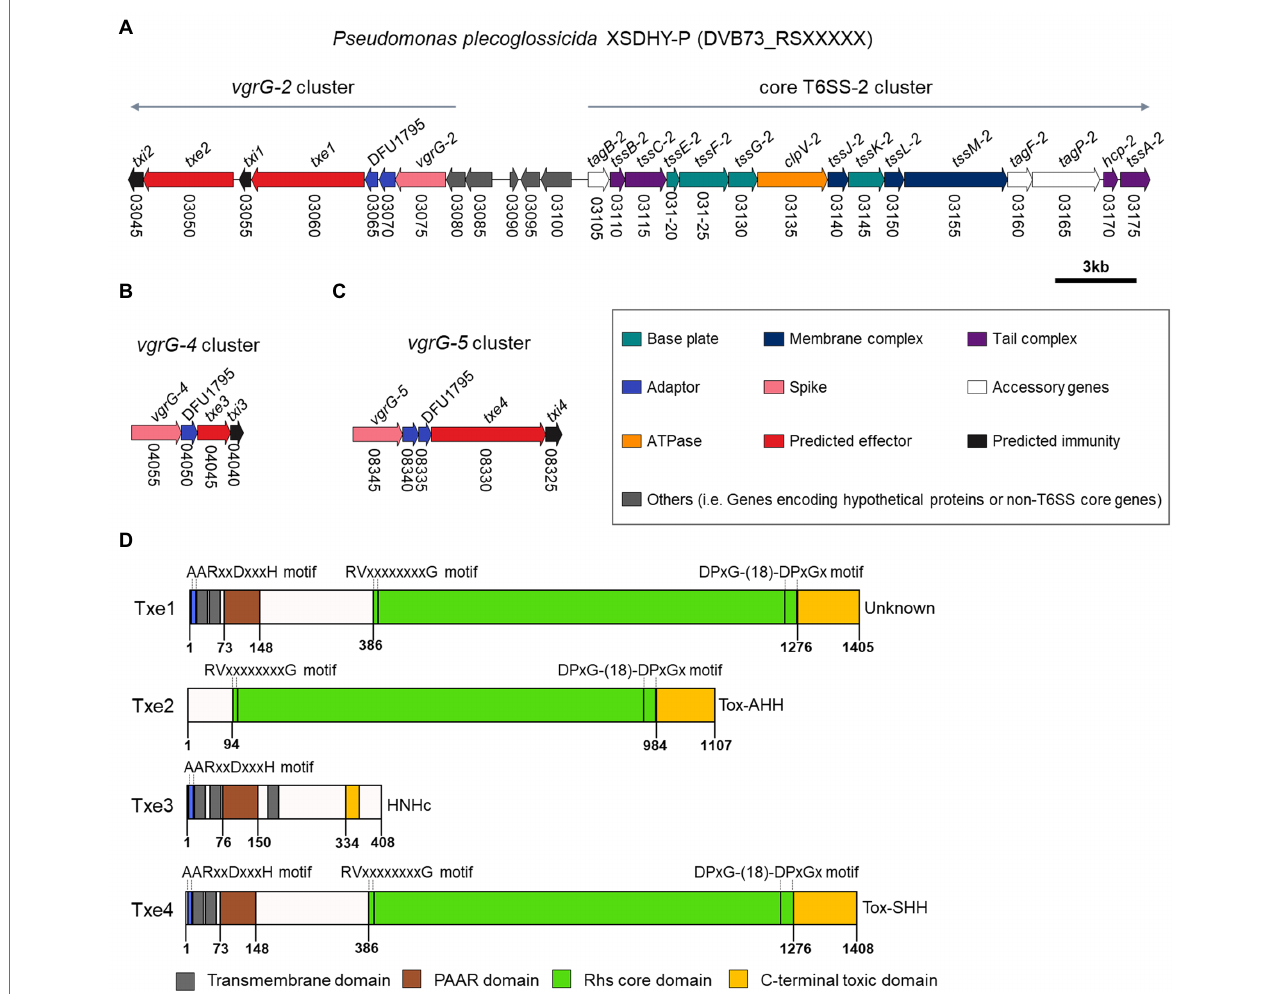
FIGURE 2 | Genomic organization of T6SS-2 main cluster and vgrG-2 cluster (A) , vgrG-4 cluster (B) , and vgrG-5 cluster (C) from P. plecoglossicida XSDHY-P. Genes are represented as arrows and the direction represents the direction of transcription. Genes are color-coded to highlight their predicted functions as described in the legend; colors specific to each gene are used to indicate genes that encode similar proteins in other clusters. Gene nomenclature is indicated at the top, and locus numbers are shown at the bottom. Predicted domain composition of four putative antibacterial T6SS effectors identified from P. plecoglossicida XSDHY-P (D) . Prediction was determined using the NCBI Conserved Domain Database tool (Marchler-Bauer et al., 2017). Schematic diagrams show the linear organization of relevant domains of putative effectors Txe1, Txe2, Txe3, and Txe4. The domains shown are: prePAAR motif (blue); transmembrane helices (dark grey); PAAR domain (brown); Rhs core domain (green); and C-terminal toxic domain (orange) as described in the legend. The lengths of the effector proteins and different domains are drawn to